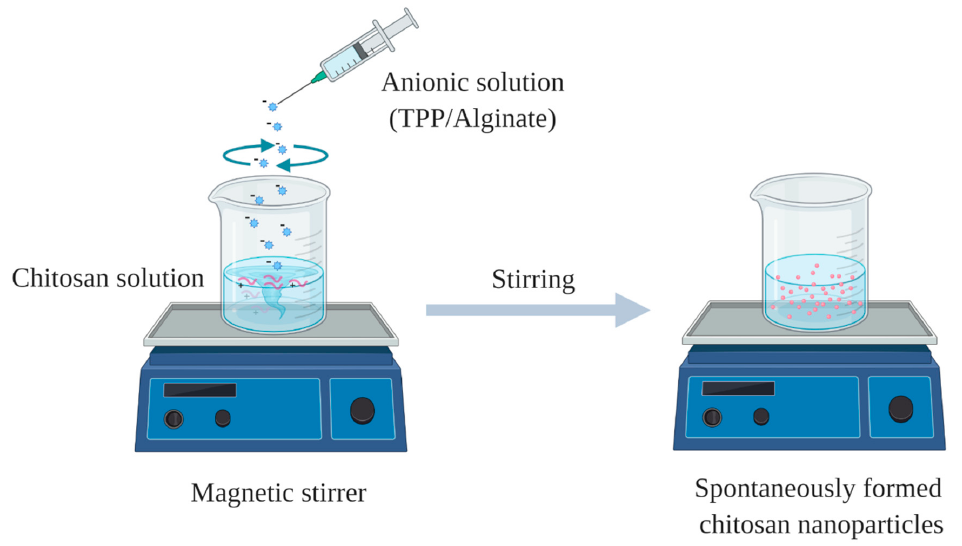
Figure 5. Schematic diagram of chitosan nanoparticles prepared via ionic gelation/polyelectrolyte complexation.